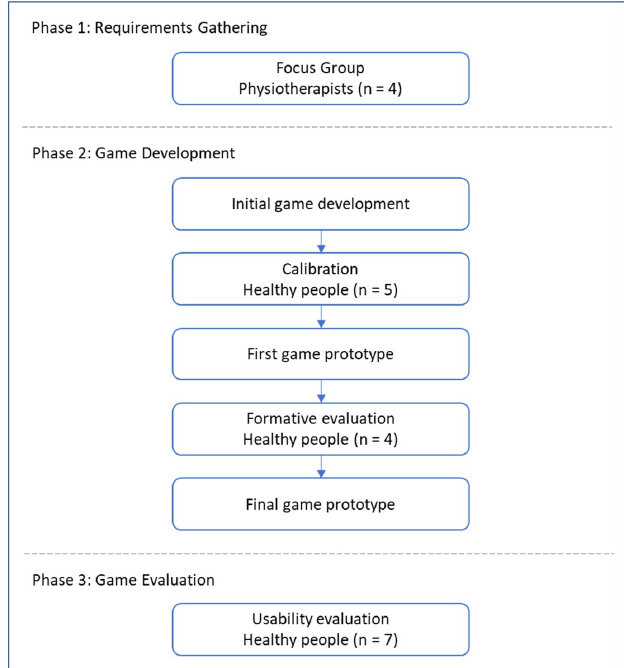
Figure 1. The development process of the game.